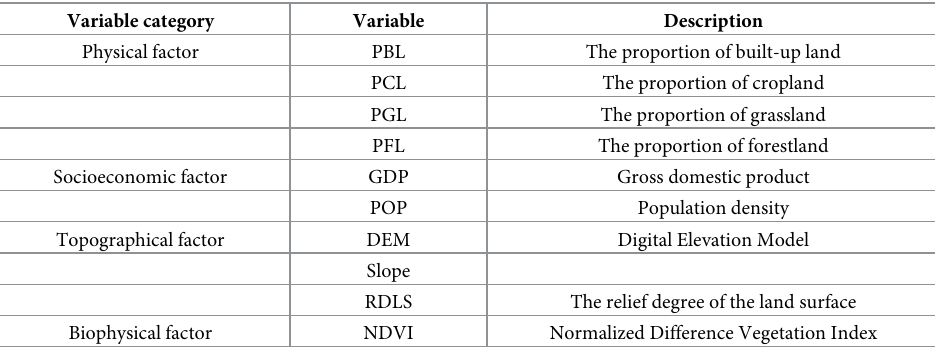
Table 1. Variable